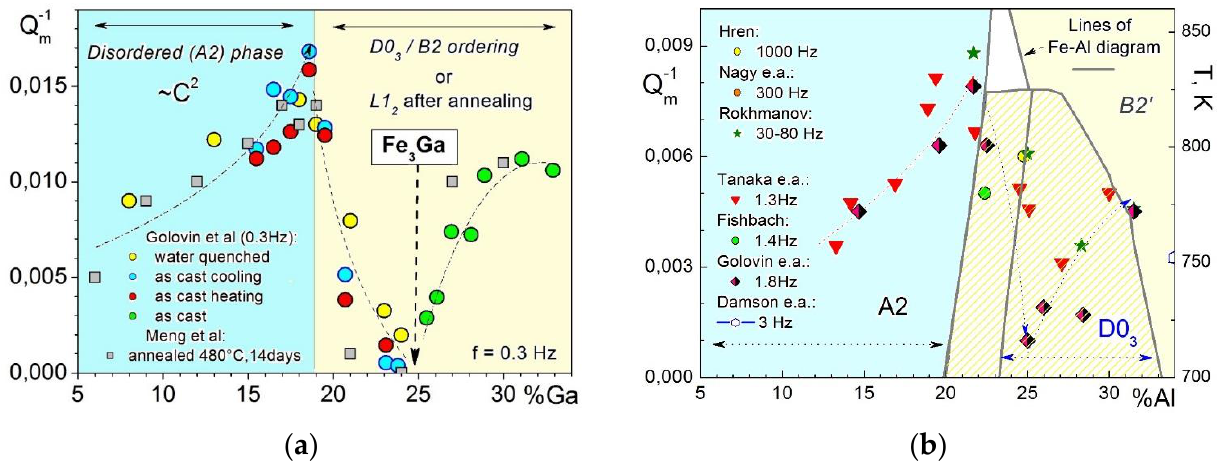
Figure 23. Dependence of the P2 Zener peak height on Ga content for alloys in metastable state (as quenched to as cast for forced bending vibrations) by Golovin [49] and in nearly equilibrium state (annealed at 480 °C for 14 days for forced torsion vibrations) by Meng et al. [61] ( a ). The same dependence for Fe–Al system for free-decay torsion and bending vibrations adapted from [66,68,138] ( b